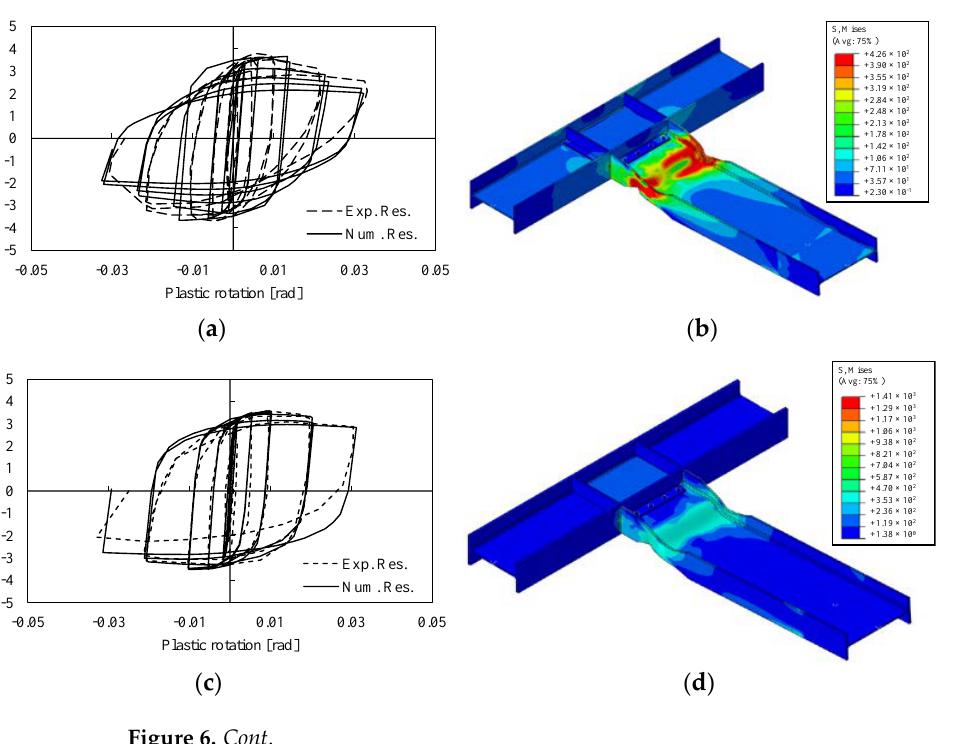
( f ) Figure 6. Comparison between the experimental [8] and numerical results in terms of moment– plastic rotation curves ( a , c , e ) and damage pattern ( b , d , f ) for all considered specimens tested in [8]. As can be observed in Figure 6, the FEM is able to mimic the experimental results in terms of moment–plastic rotation curves; moreover, the equivalent plastic deformations are consistent with the experimental damage pattern in [8]. To the a best of the authors’ knowledge, the results of fire tests on seismically dam- aged RBS joints are not available in the literature. Therefore, in this study, the same mod- elling assumptions adopted by Tartaglia et al. [3] were implemented. In fact, the FEM in [3] were validated against fire tests on steel joints, and their predictive accuracy is deemed satisfactory. 4. Results of Parametric FEAs 4.1. Seismic Behaviour The results of both external and internal joints under cyclic loading at ambient tem- perature are depicted in Figure 7 in terms of moment–rotation curves (where the moment has been normalised to the plastic moment of the beam M pl,Rd ) and damage pattern, show- ing the distribution of the equivalent plastic deformations (PEEQ). For the sake of brevity, only the distribution of PEEQ of the joints is shown at 0.06 rad. As can be observed, the normalized response curves of RBS-80 and RBS-65 are very similar, although there is a difference in the width of the reduced beam flange.